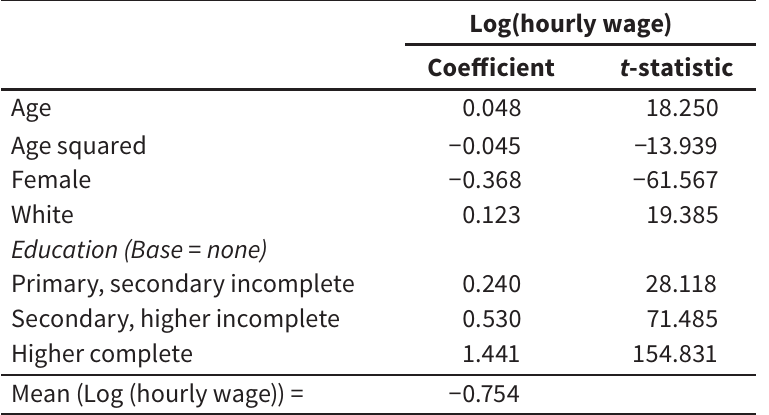
Coefficients and t-statistics of prediction of wages for migrants based on past migrants at the destination,